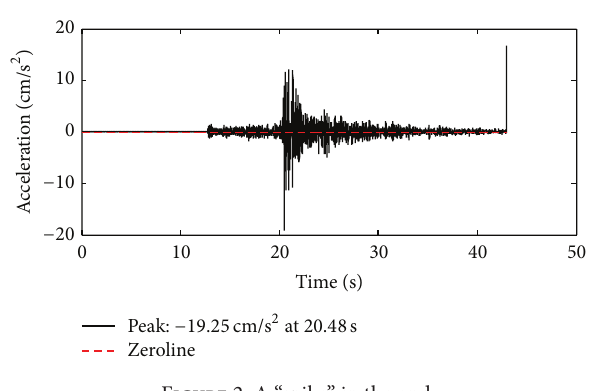
Figure 2: A “spike” in the